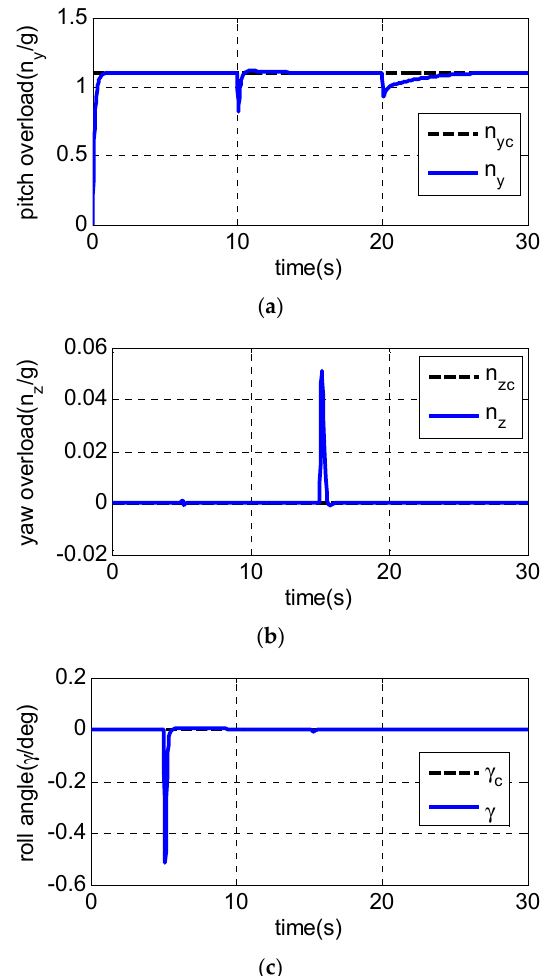
Figure 3. Simulation results of command tracking of three channels: ( a ) pitch overload; ( b ) yaw overload; and ( c ) roll